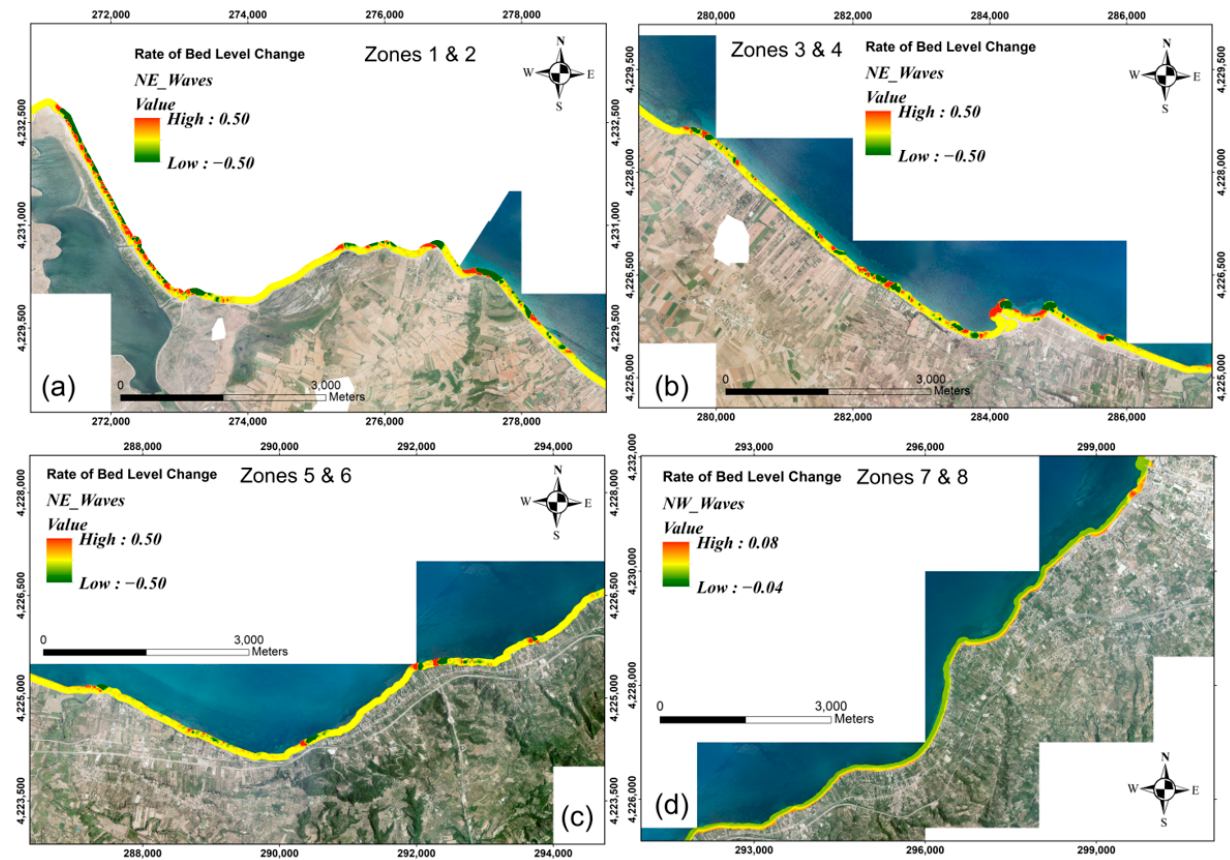
Figure 16. Seabed level change in ( a ) coastal zones 1 and 2, ( b ) zones 3 and 4, ( c ) zones 5 and 6 due to NE waves, and ( d ) coastal zones 7 and 8 due to NW waves. These are the most a ff ected sea bed level change winds in the respective areas. Table 2. Erosional intensity in the 8 zones of the study area with respect to the wind direction. Zone